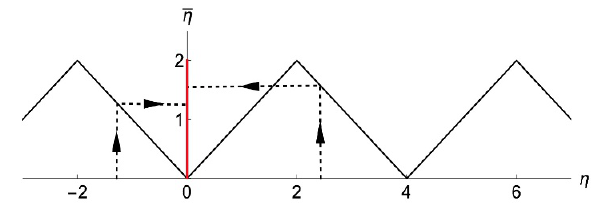
Figure 1. Folding transformation R 3 (cid:17) 7! (cid:22) (cid:17) 2 [0 ;